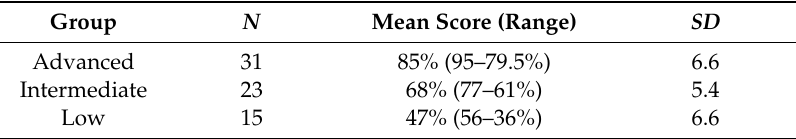
Table 1. Descriptive statistics for participants’ proficiency in